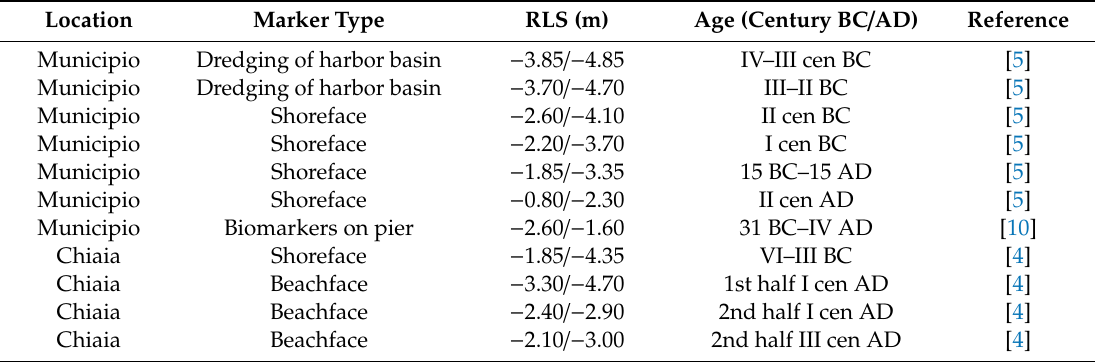
Table 1. Table of Greek-Roman relative sea level (RSL) from previous geoarchaeological studies